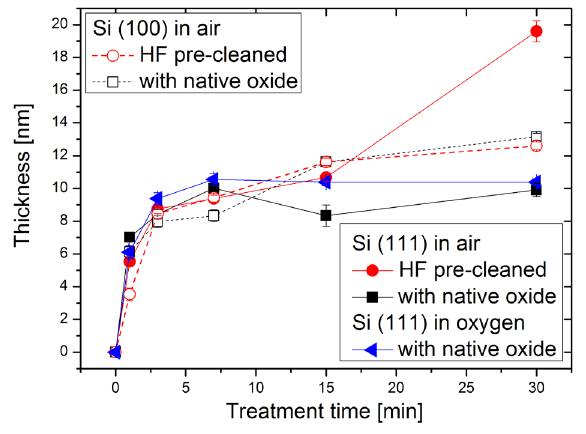
Figure 2 : Thickness of the oxide layer as a function of treatment time for both, Si (111) and SI (100), surfaces with native oxide and HF pre-cleaned and oxidized in air plasma. The oxidation process is compared with results from the oxygen